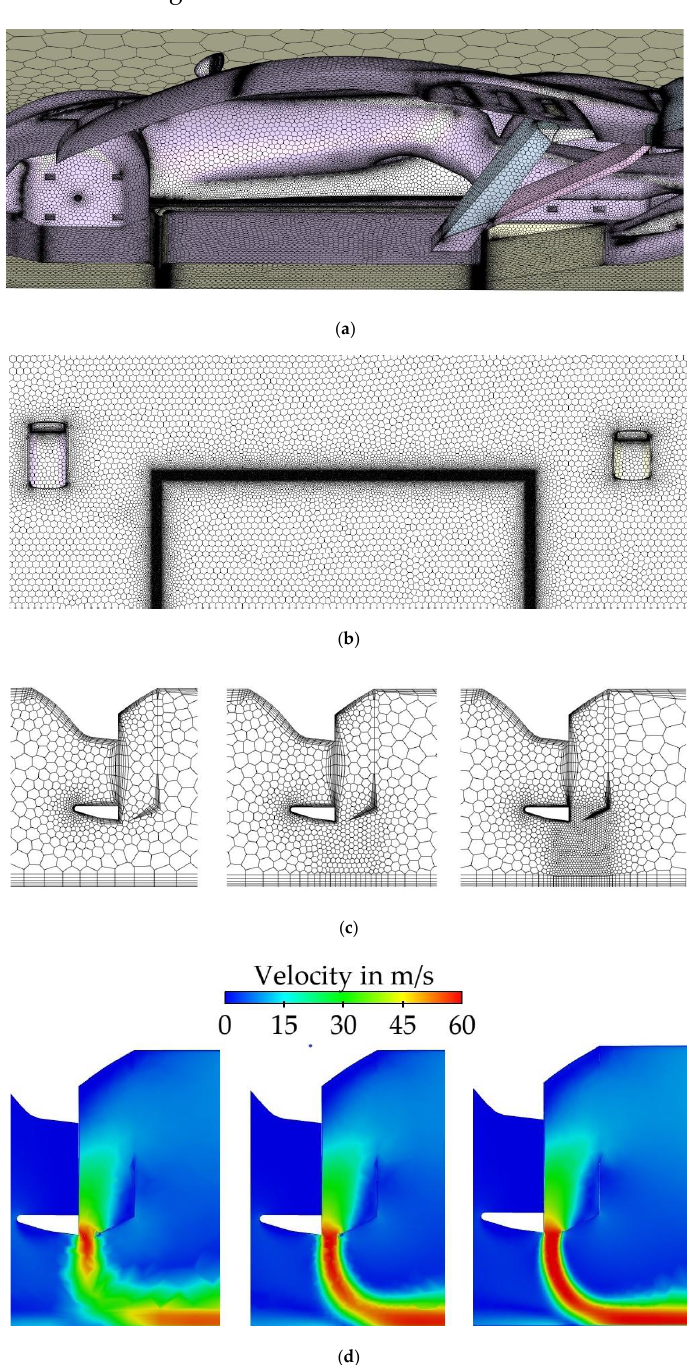
Figure 22. Grid convergence test in the undercarriage area: ( a ) Cross-section view, refinement in the proximity of curtains can be seen; ( b ) Ground view from the bottom; ( c ) Zoom at the front nozzle, various mesh sizes; ( d ) Velocity contours at the front nozzle for various mesh sizes. Simulations were performed for all three meshes for the case of a stationary car and fans running at 3000 Pa. The monitored parameter was an aerodynamic downforce acting on the car, as well as a drag and volumetric flow rate through all the fans. As shown in Table 1, the relative differences of observed parameters did not exceed 2% after the first